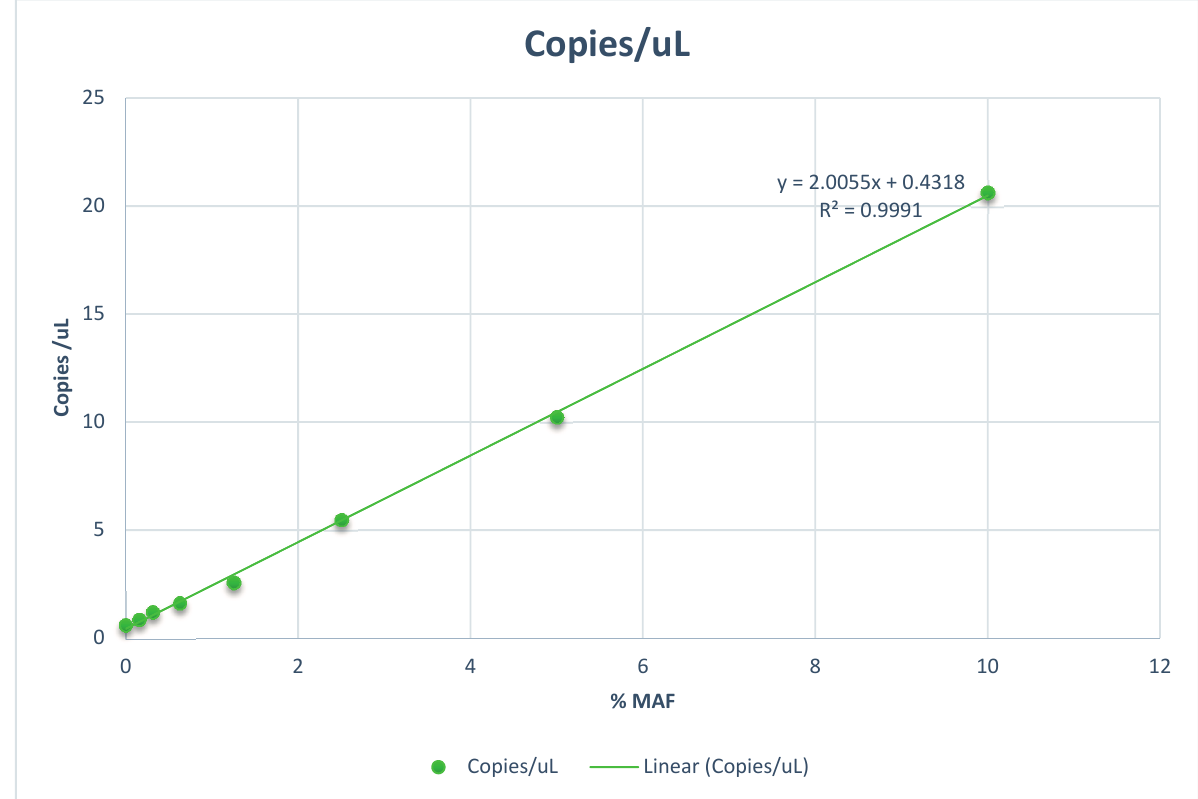
Figure 1. Limit of detection curve for AKT1 c.49G>A p.E17K using combined allele specific PCR and digital